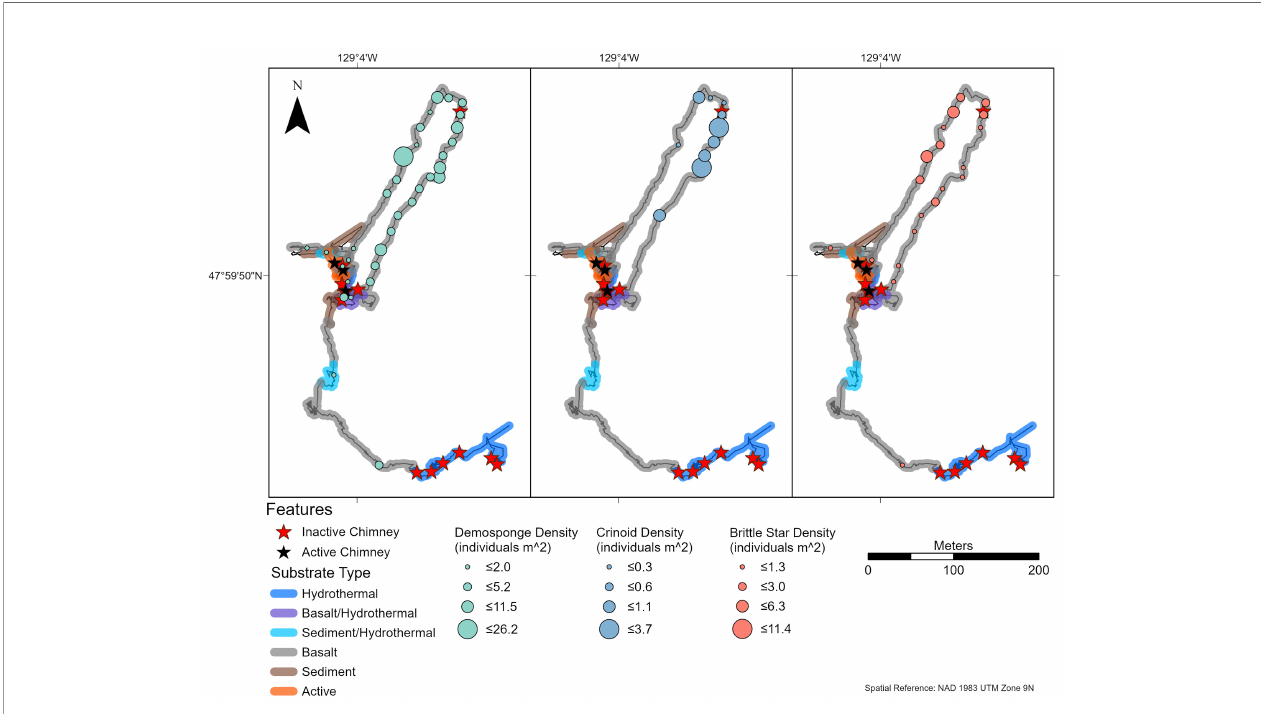
FIGURE 7 | Density of brittle stars (Ophiuroidea spp.), comatulid crinoids (Comatulida sp. 1), and demosponges (Demospongiae sp. 1) on dive R1938, at the Endeavour Segment of the Juan de Fuca Ridge sampled in August 2016. Each symbol indicates density in an image captured at that location. These three morphotaxa were identi fi ed as the numerically dominant faunal groups (present in ≥ 25% of images) (n = 20, 10, 33 for Ophiuroidea spp., Comatulida sp. 1, and Demospongiae sp.1, respectively). “ Hydrothermal ” substrate refers to inactive substrate that is hydrothermally